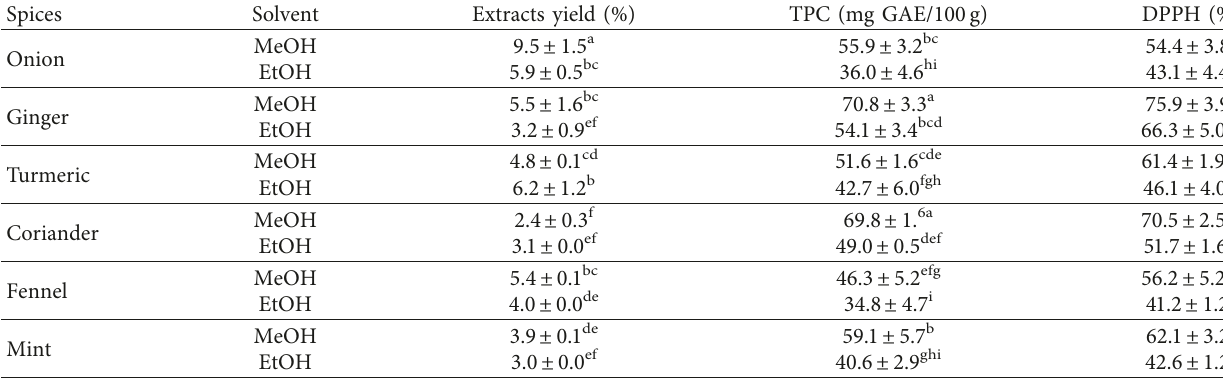
Table 3: Extracts’ yield, total phenolic contents, and antioxidant potential of